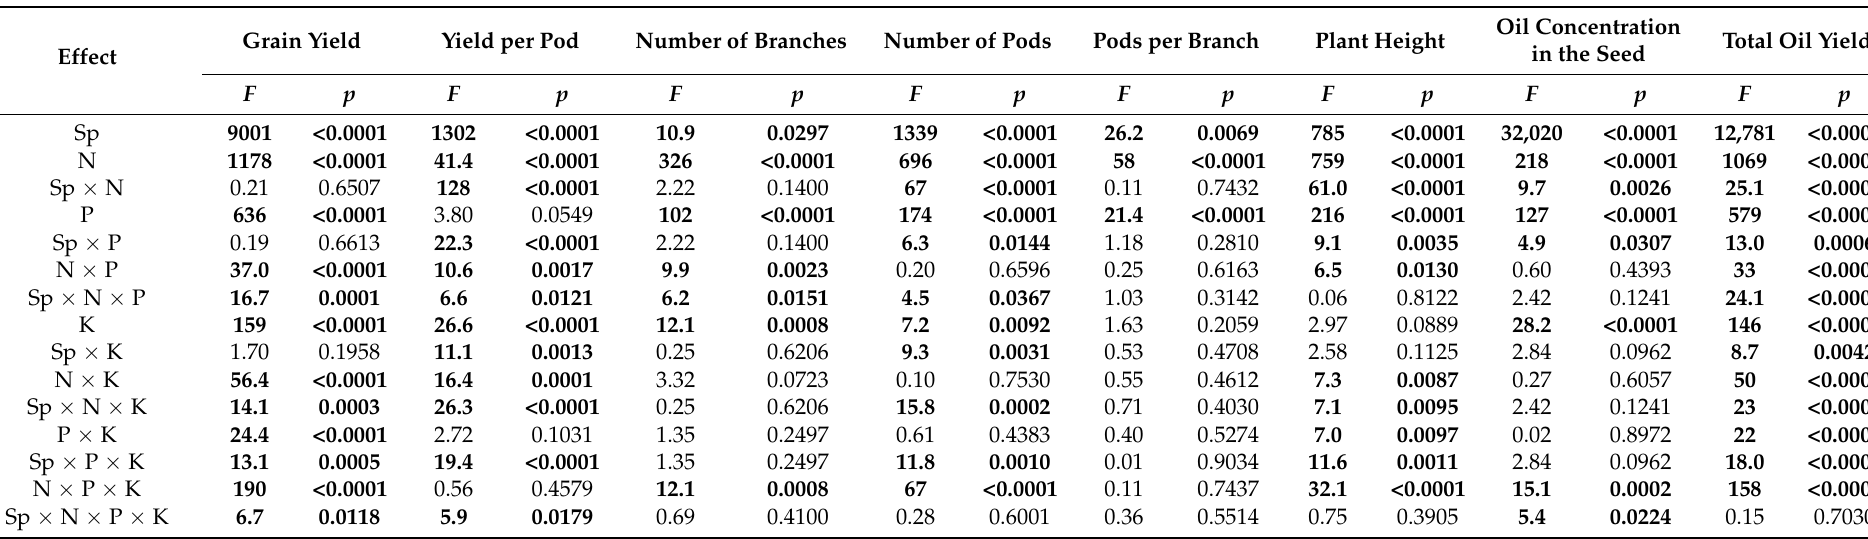
Table 1. F statistics and p values of the general linear mixed model applied to the yield, yield components, and plant height of Evening Primerose and Rapeseed as affected by ferlizer application. Factors were the plant species (Sp) and each of the three main nutrients added as a fertilizer (N, P, K). Plant species were Evening Primrose or Rapeseed and each fertilizer factor had two treatments: either added or not. Fertilizers were nested into Sp. When the p -values were lower than 0.05, F and p are shown in